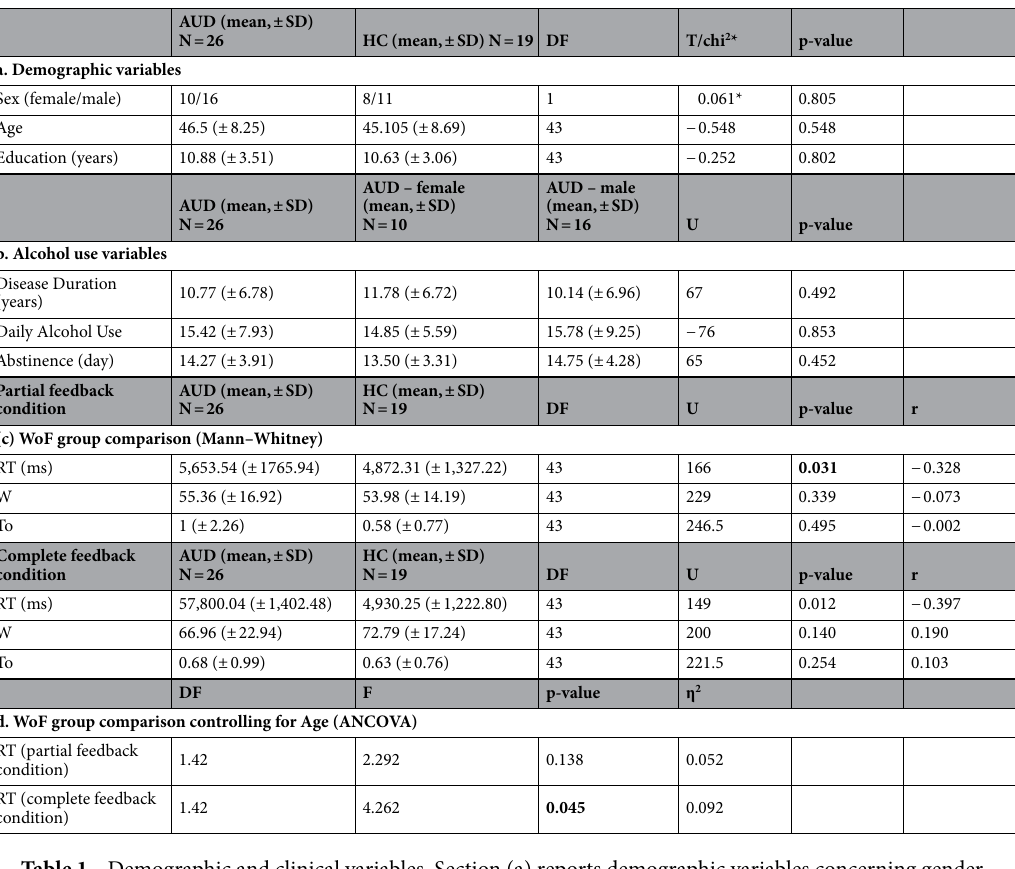
Table 1. Demographic and clinical variables. Section (a) reports demographic variables concerning gender, age and education for both AUD patients and healthy controls. Section (b) reports clinical information about alcohol use history and daily dose in AUD patients. Section (c) reports information about partial and complete feedback conditions (mean, standard deviation), concerning response time, gain and time-out variables obtained at the WoF task for AUD patients and healthy controls. Section (d) reports information about group differences in RT, corrected for the effect of age (ANCOVA). (*) indicates results from chi square test; all other analyses of group differences are based on non-parametric Mann–Whitney U tests for independent samples. PF = partial feedback; CF = complete feedback; AUD = AUD patients; HC = healthy controls; SD = standard deviation; DF = degree of freedom; T = Student’s t-test; chi 2 = chi square test; U = Mann–Whitney U Test; r = Rank biserial correlation; η 2 = partial eta squared; FDR = False Discovery Rate adjustment applied on raw p-values. Bold values denote statistical significance at the p < 0.05